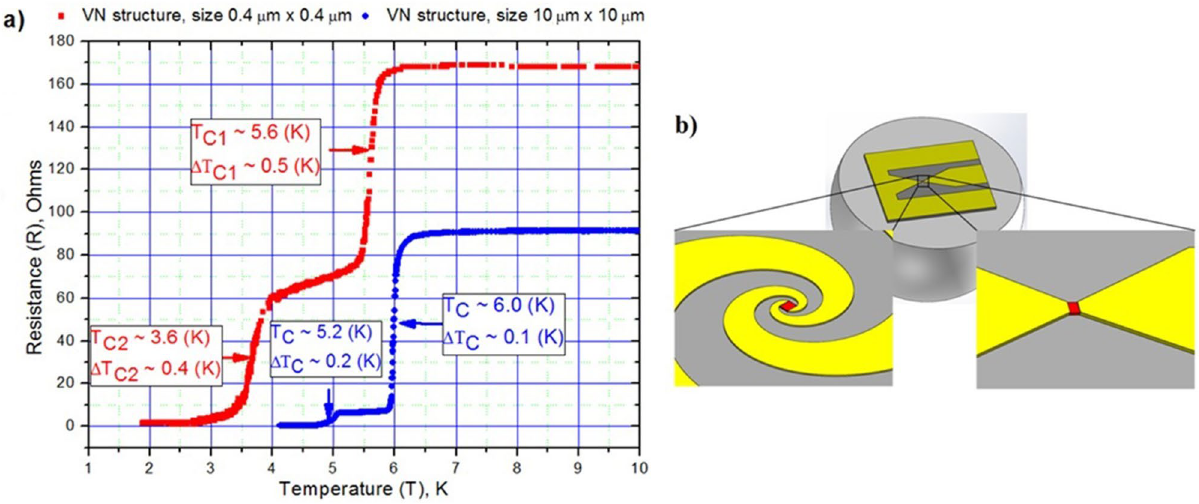
Figure 1. ( a ) The temperature dependences: the VN structure with the size of the sensitive region of 0.4 μm × 0.4 μm (red square), the VN structure with the size of the sensitive region of 10 μm × 10 μm (blue sircle). The graph also shows values of critical temperature (T c ), the transition width (ΔT c ). ( b ) Image of a chip of the studied VN structure on a Si substrate, centered at the focus of a hyper-hemispherical Si lens. The sensitive area is a red square. The sensitive area having 0.4 μm (L) × 0.4 μm (W) coupled with a spiral logarithmic antenna (left). The sensitive area 10 μm (L) × 10 μm (W)